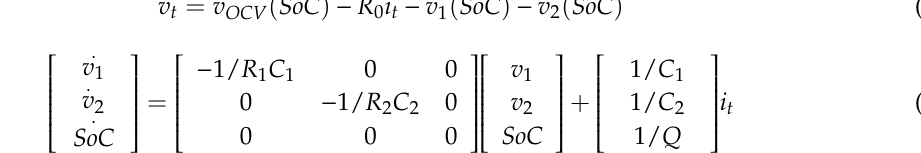
Table 1. Battery module and string specification.